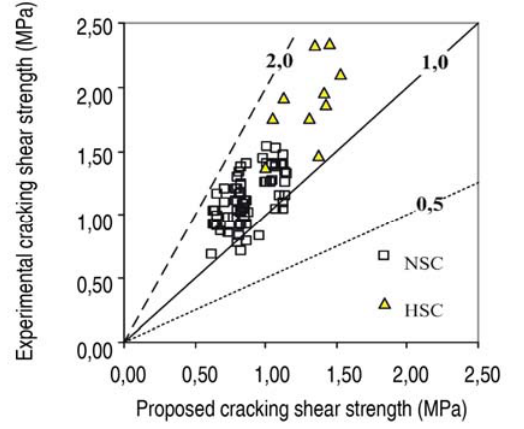
Fig. 1. Proposed cracking shear strength values using Eq (15) versus experimental cracking shear strength values